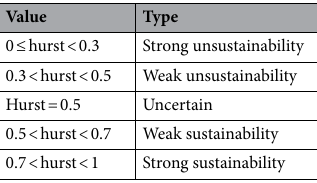
Table 4. Classification of Hurst index.